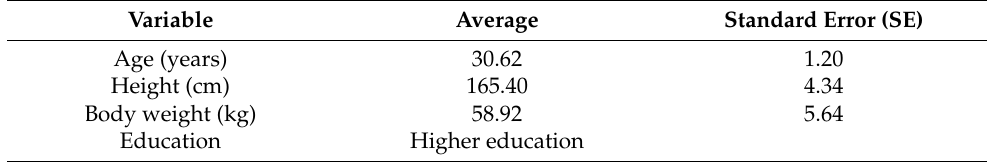
Table 1. Characteristics of participants ( n = 50).